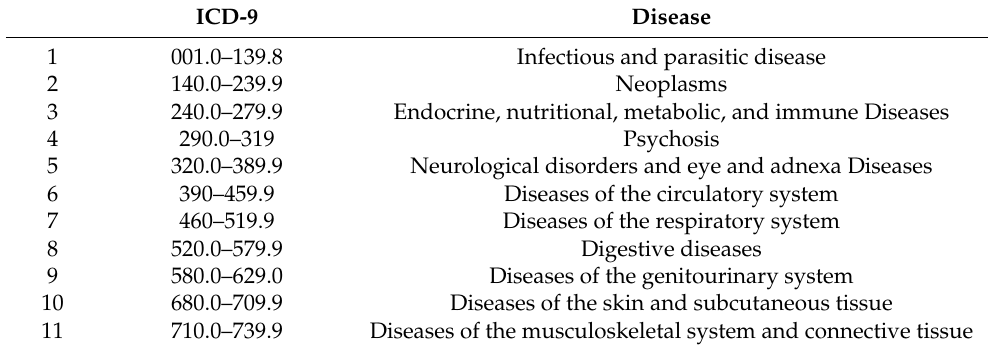
Table 1. ICD-9-CM codes to systemic